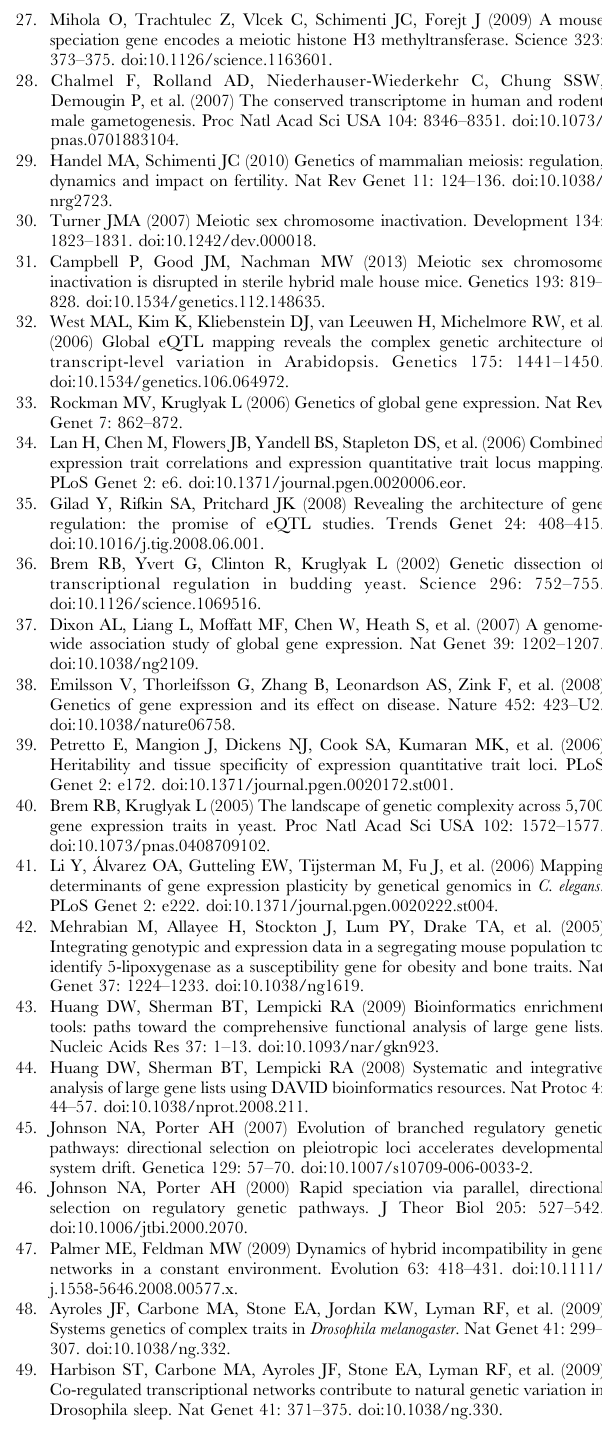
Table S3 Significance thresholds for expression quantitative trait locus (eQTL)